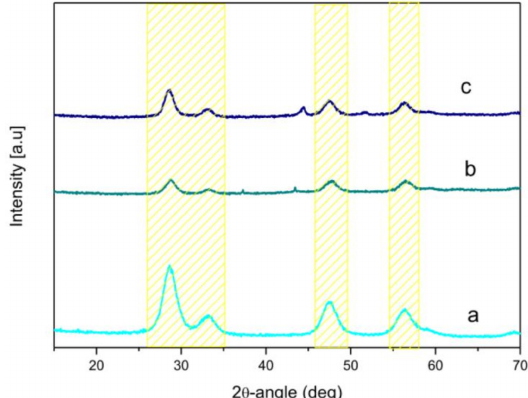
Figure 3. X-ray patterns of: GDC support (spectrum a)—NiMoRe/GDC sample after calcination (spectrum b), and after reduction (spectrum c). Features arising from the GDC support are